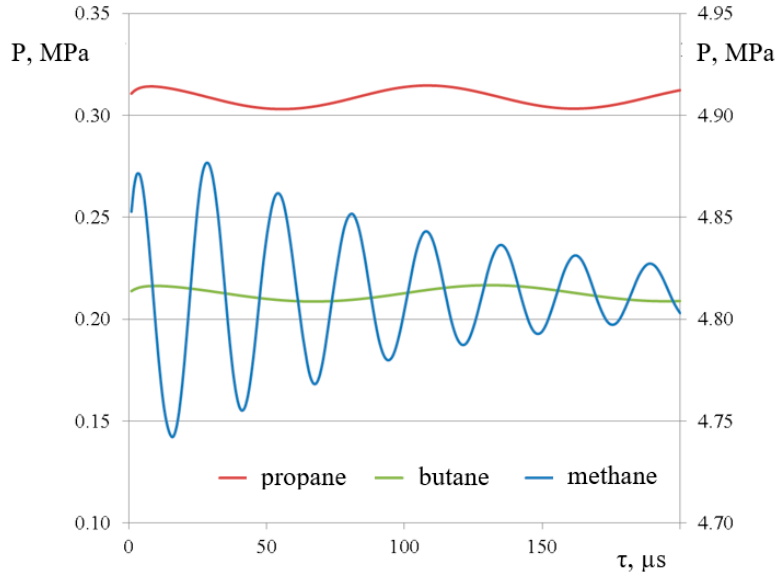
Figure 11. Inside bubble gas pressure (methane-right axle, propane and isobutane-left).